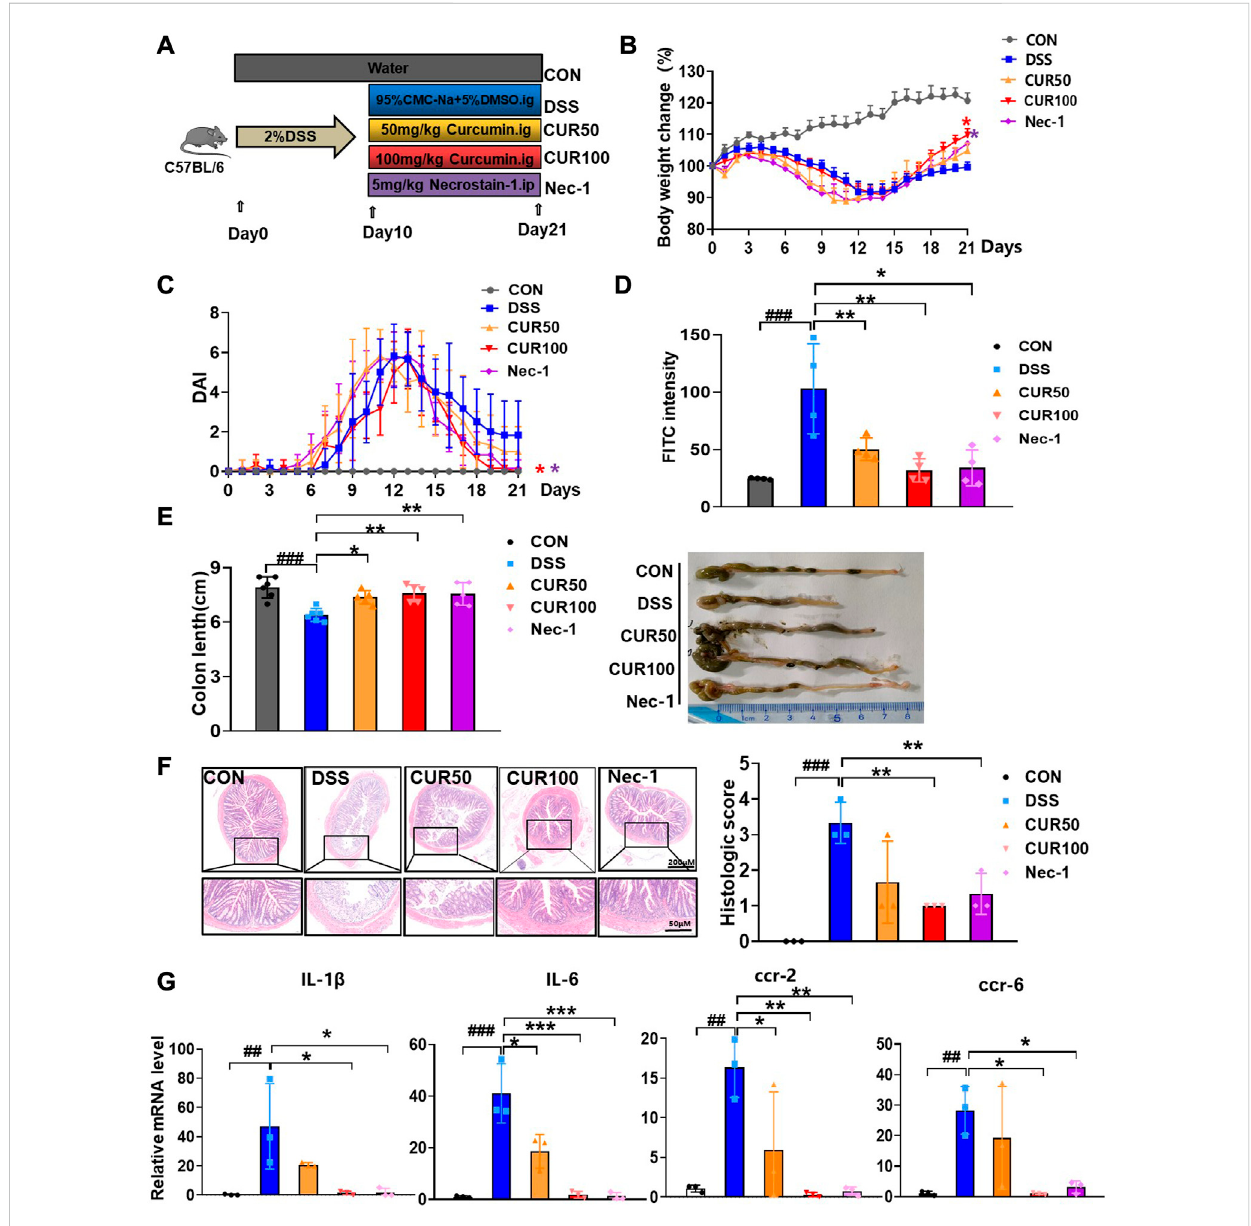
Curcumin alleviates symptoms of DSS-induced colitis. (A) Experimental protocol for the treatment of ulcerative colitis with curcumin (n = 6-8). (B) Body weight change. (C) Disease activity index (DAI). (D) FITC content of blood from mice 4 h after gavage. (E) Analysis of colon length and colon condition of mice in each group on the last day. (F) Representative images of H&E staining of mouse colon as well as histologic scores. (G) Quantitative analysis of in fl ammatory cytokine RNA in mouse colon tissue. (## p < 0.01, ### p < 0.001, compared with CON group; * p < 0.05, ** p < 0.01, *** p < 0.001, compared with DSS